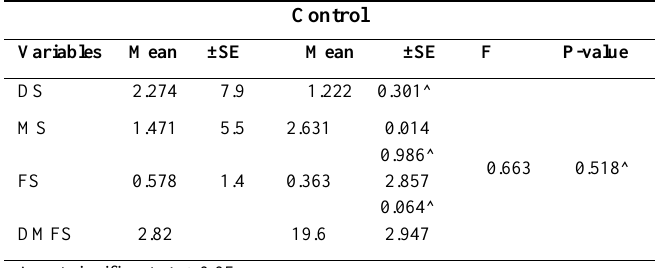
Table 1 : Descriptive and statistical test of caries experience among